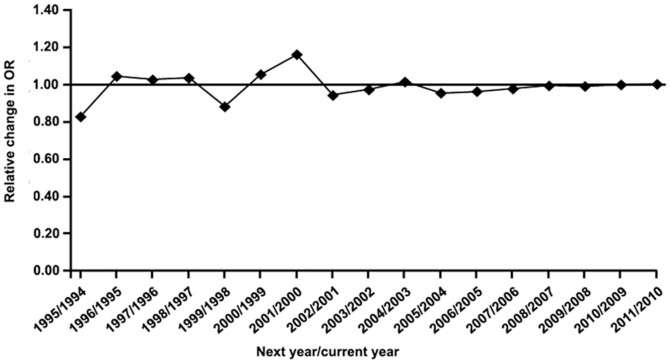
Results of the recursive cumulative meta-analysis.The relative change in random effects pooled OR in each information step (OR in the next year/OR in the current year) for the recessive model is shown.